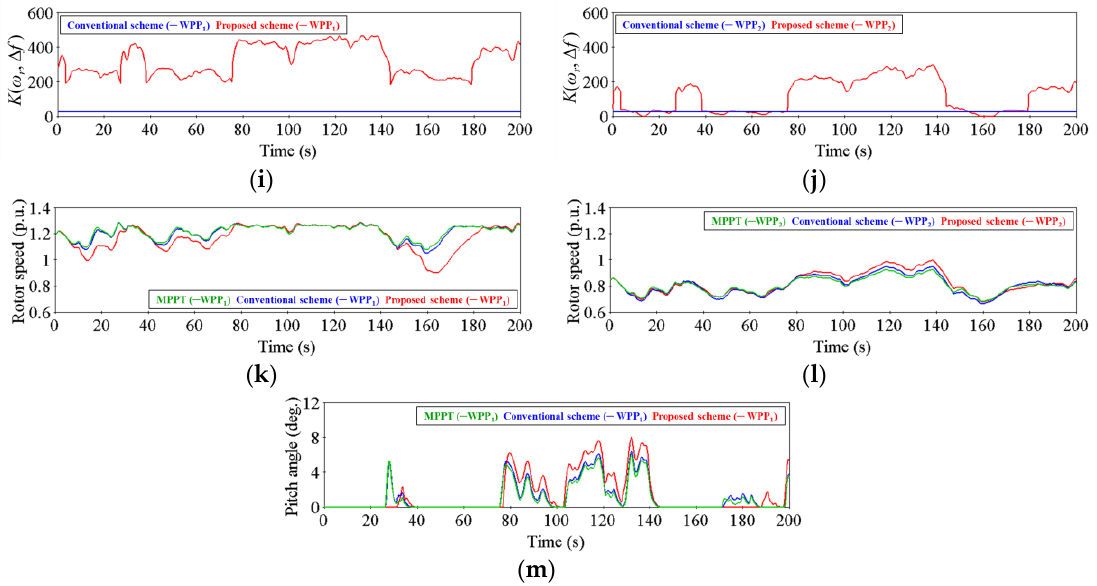
Figure 8. Results for Case 2. ( a ) Frequency; ( b ) Total output power of two WPPs; ( c ) Output power of WPP 1 ; ( d ) Output power of WPP 2 ; ( e ) P MPPT of WPP 1 ; ( f ) P MPPT of WPP 2 ; ( g ) Δ P of WPP 1 ; ( h ) Δ P of WPP 2 ; ( i ) K ( ω r , Δ f ) of WPP 1 ; ( j ) K ( ω r , Δ f ) of WPP 2 ; ( k ) Rotor speed of WPP 1 ; ( l ) Rotor speed of WPP 2 ; ( m ) Pitch angle of WPP 1